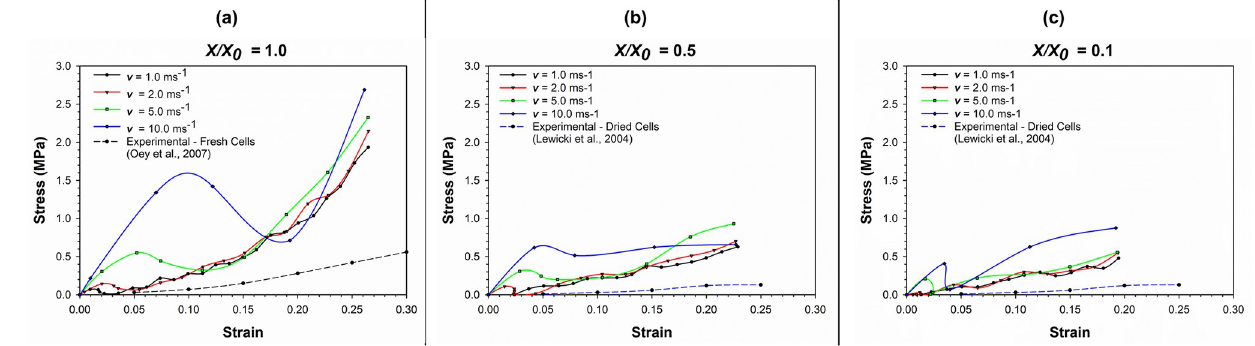
Fig 11. The stress-strain relationship of cells as affected by varying compression rates. (a) fresh cells ( X/X 0.5); (c) extremely dried cells ( X/X